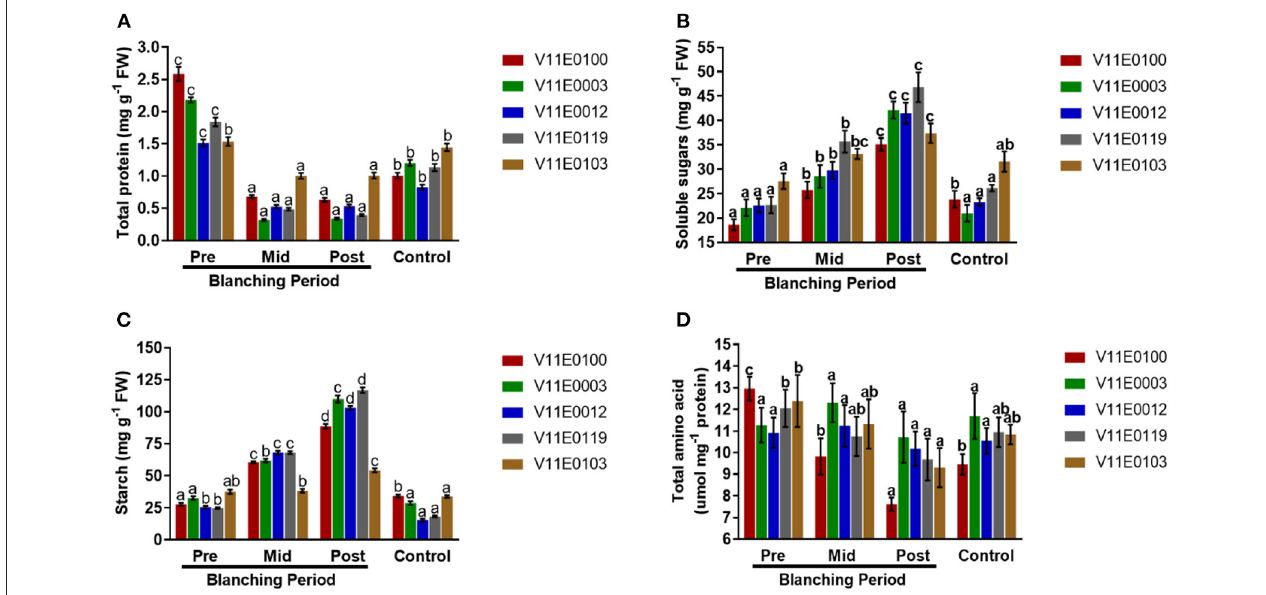
FIGURE 4 | Effect of blanching on the (A) total protein content, (B) soluble sugars content, (C) starch content, and (D) total amino acid content in the stem of five water dropwort cultivars. Four types of samples were analyzed; Pre-blanching, Mid-blanching (20 days), Post-blanching (40 days), and Control (grown under normal conditions). Different letters indicate a significant difference ( P < 0.05) among the treatments according to the Tukey test. Values are means ±